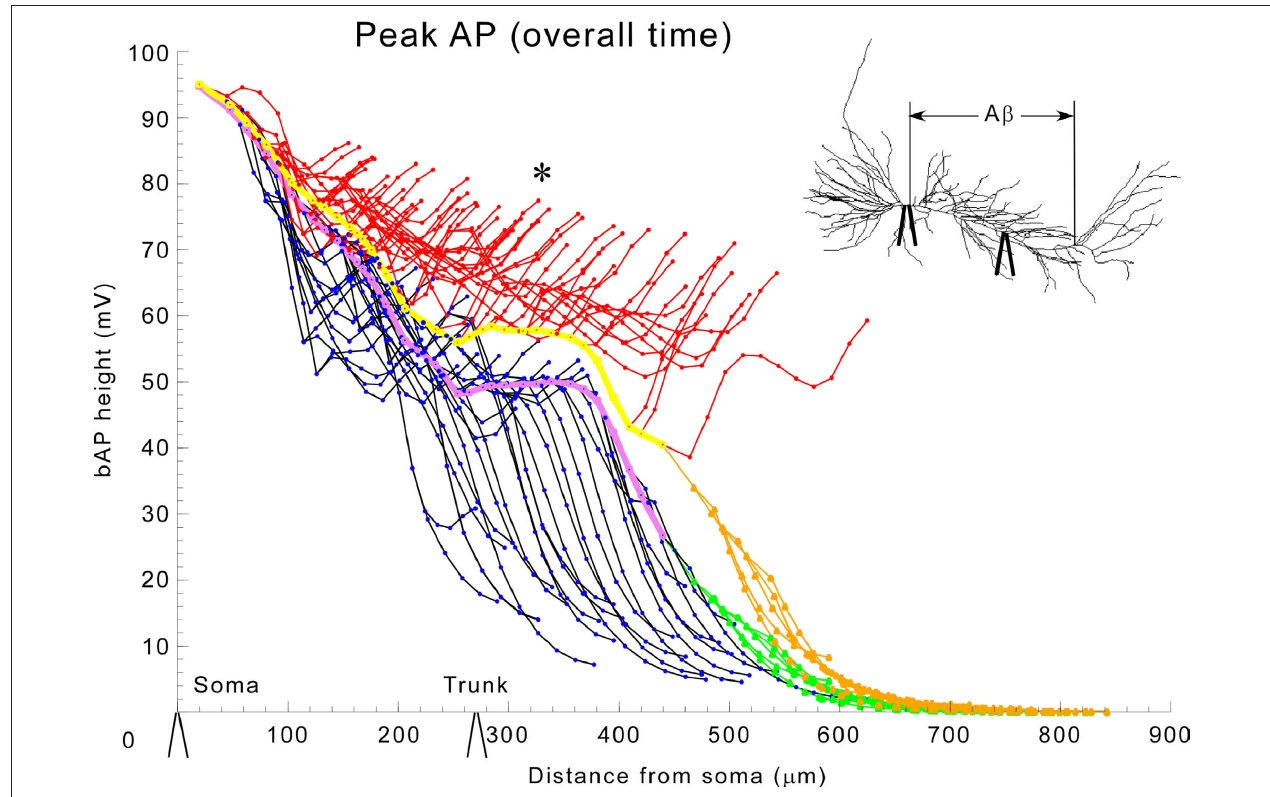
red-oblique dendrites, yellow-trunk, tan-apical tuft. Asterisk indicates abnormally large amplitude in the oblique dendrites. The inset shows that a β ( I applied only to the oblique dendrites. (See Figure 2 for electrode